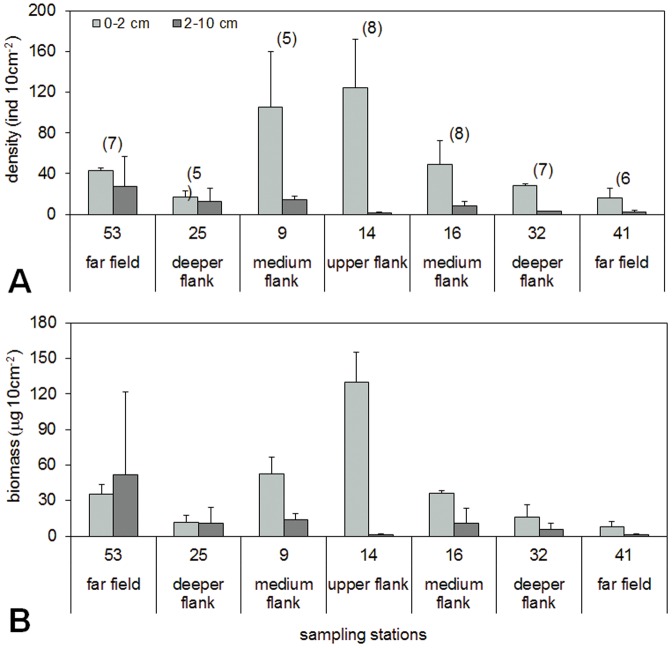
Preliminary meiofaunal abundance and biomass data for the two sediment layers of each station.Values averaged over replicates collected in the same deployment: bars denote standard error. A: abundance (individuals 10 cm−2), in brackets the number of taxa, B: biomass (µg 10 cm−2, the values have been calculated with the gravimetric method).